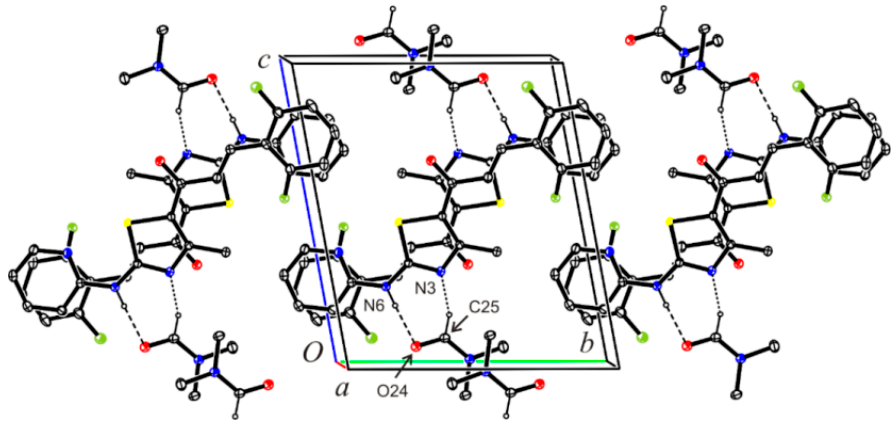
Figure 3. ORTEP view of the molecular packing in the crystal structure of 3 *DMF.